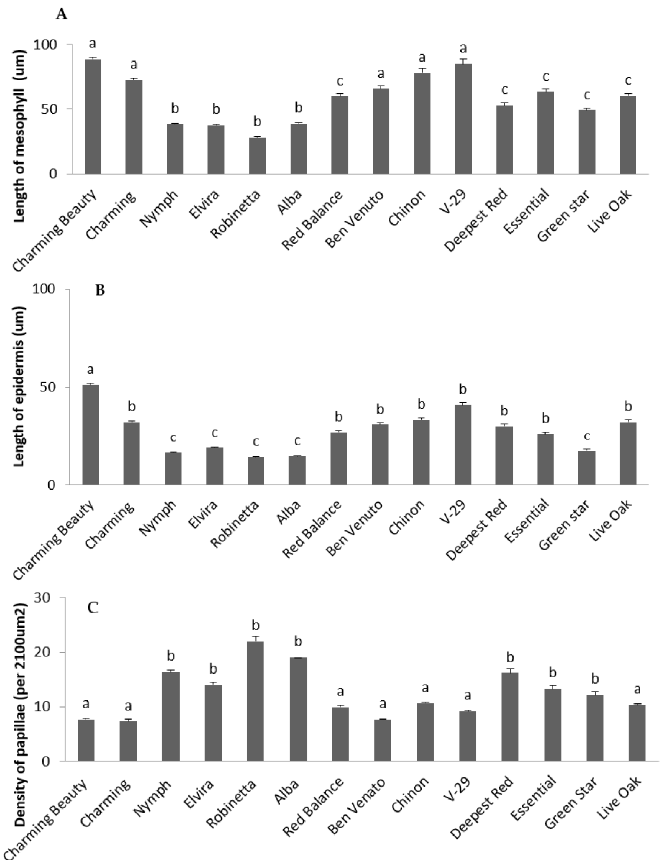
Figure 3. The length of mesophylls ( A ) and epidermal cells ( B ) and the density of papillae ( C ) in 14 Gladiolus varieties. Data represent means and standard errors for three to five replicates. Different letters indicate significant differences between varieties at p ≤ 0.05.